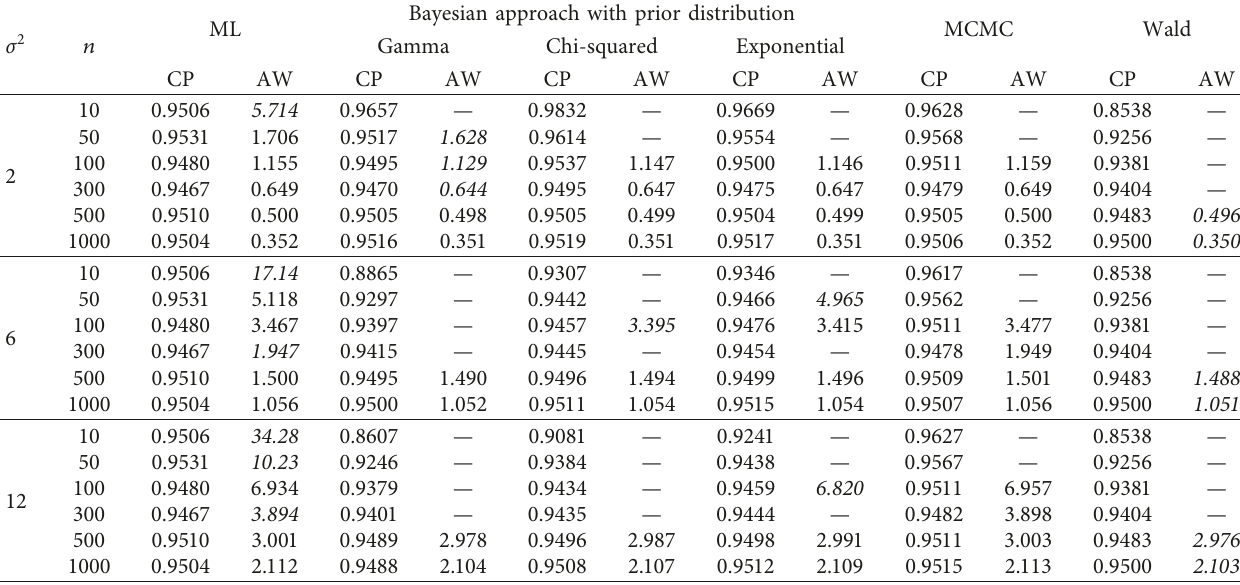
Table 3: The coverage probability (CP) and average width (AW) via 95% confidence